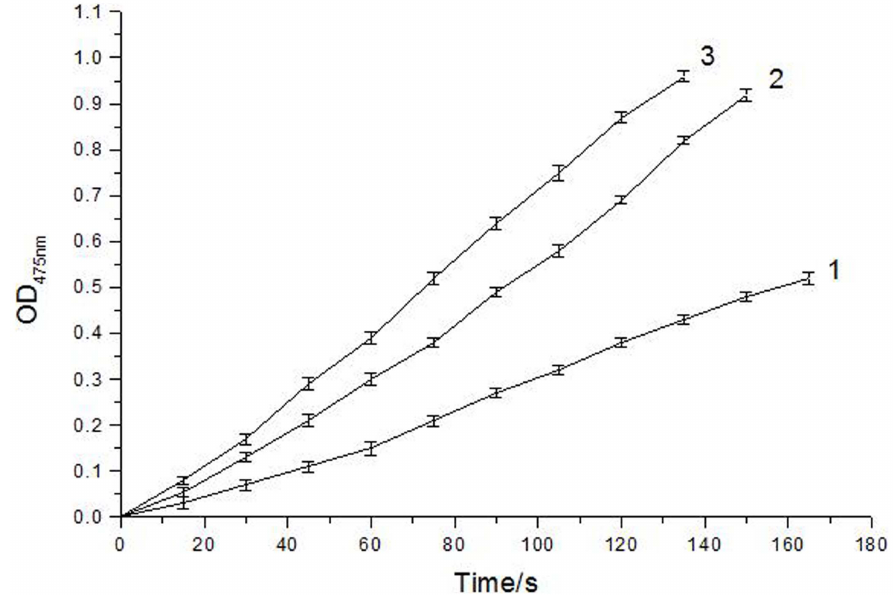
Figure 4. Progress curves for the activation of diphenolase of mushroom tyrosinase by a -arbutin . The reaction media (3.0 mL) contained 0.5 mM L-Dopa in 50 mM phosphate buffer (pH 6.8), the indicated concentration of a -arbutin, and mushroom tyrosinase (6.67 m g/mL). The concentrations of a -arbutin for curves 1 , 3 were 0, 5, 10 mmol ? L 2 1 .